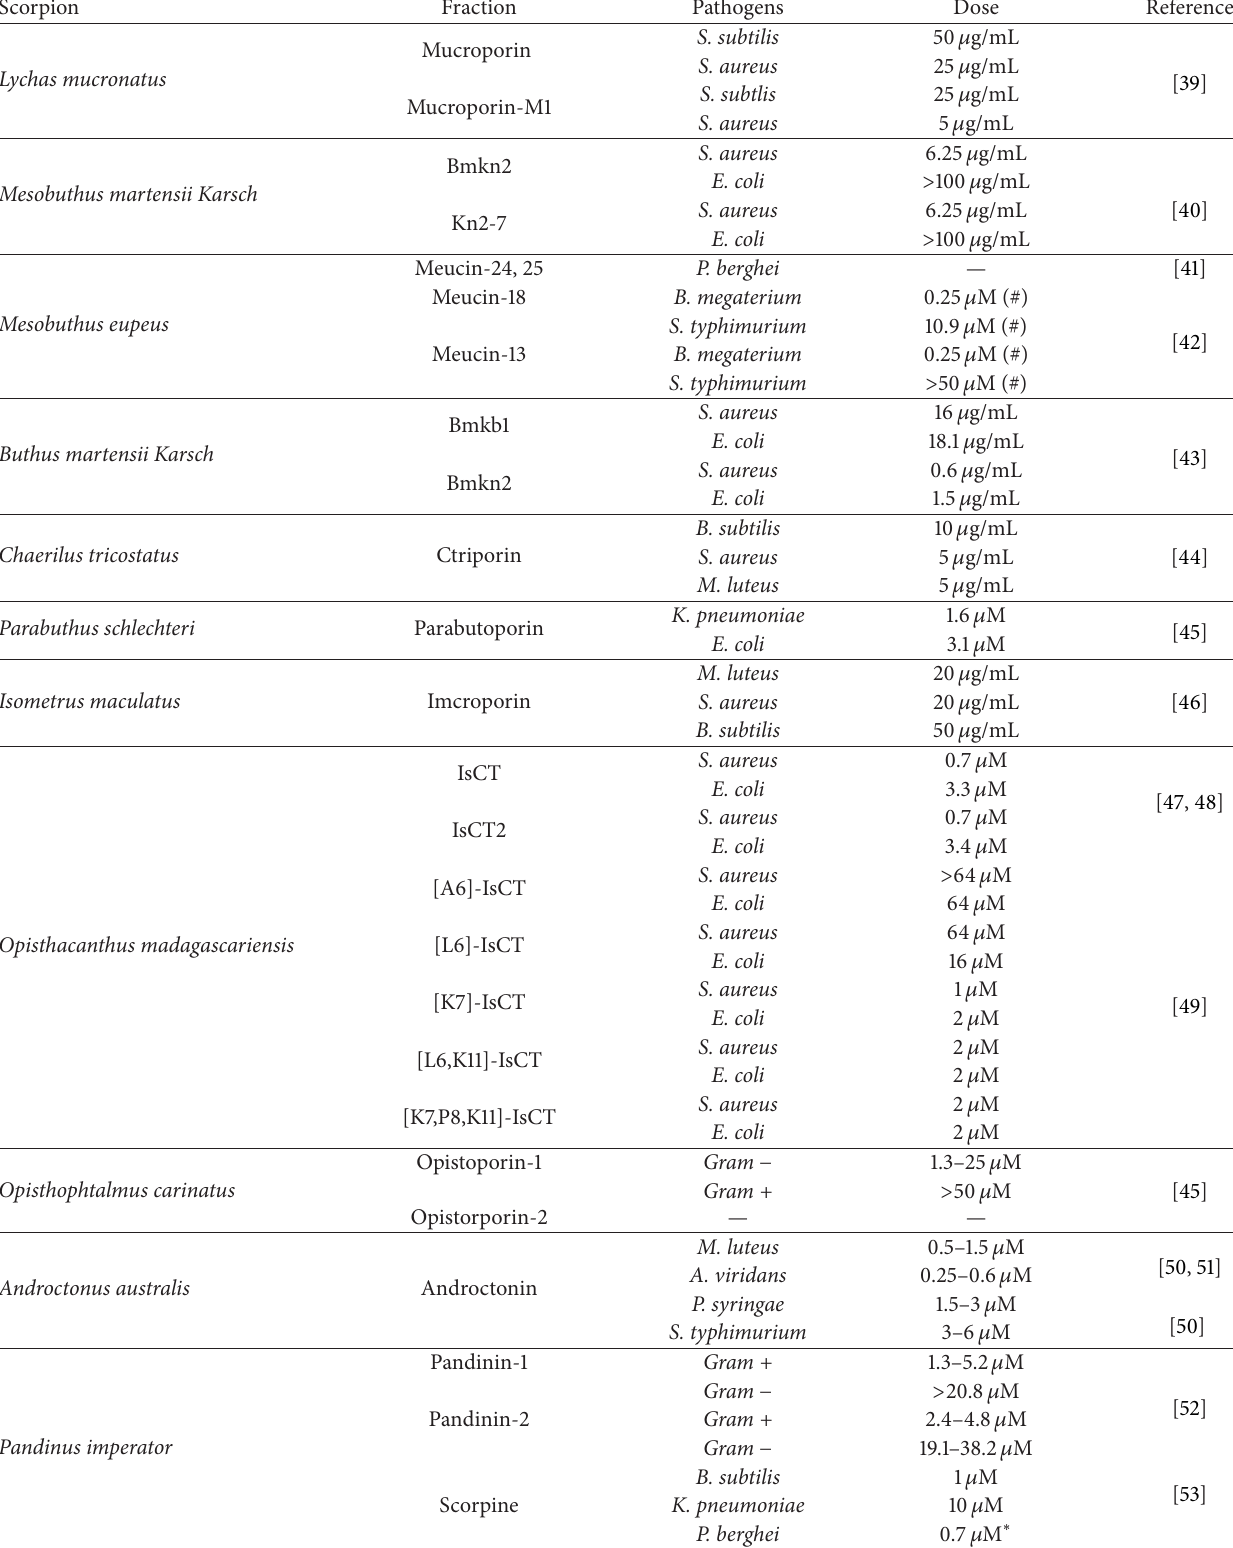
Table 2: List of antibacterial peptides isolated from